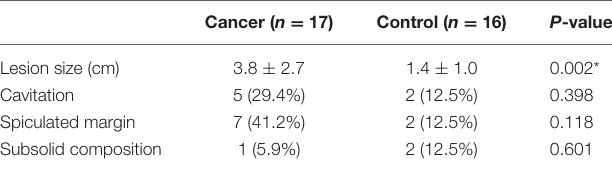
TABLE 2 | CT imaging characteristics of pulmonary lesions.